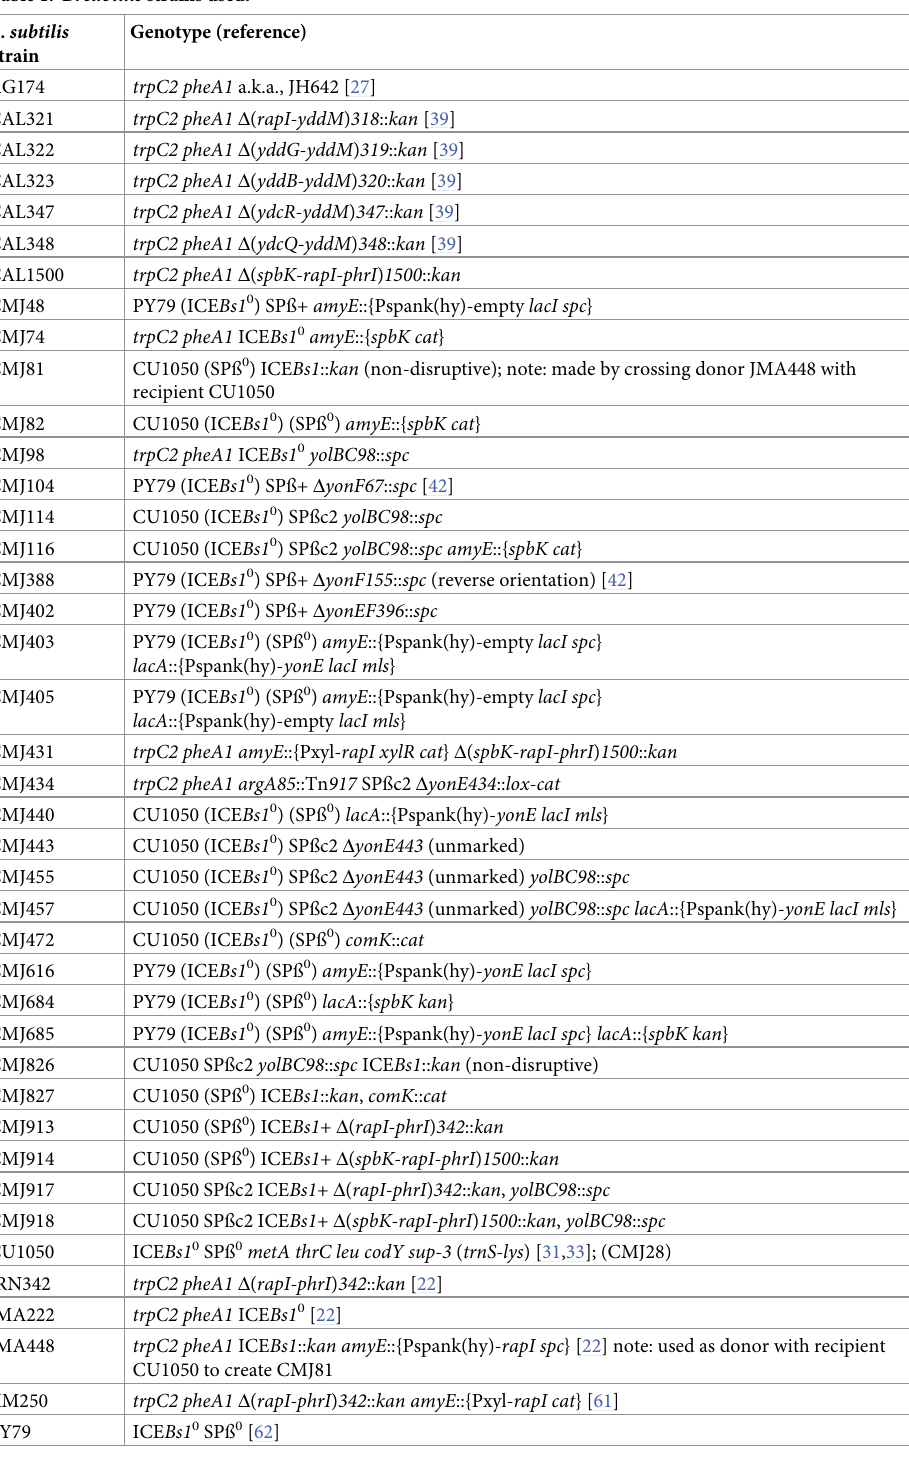
Table 1. B . subtilis strains used. B . subtilis